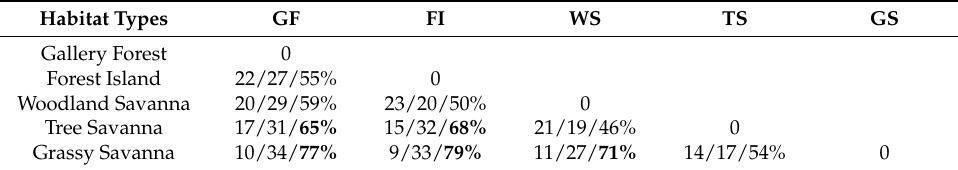
Table 2. Dissimilarity assessment of termite assemblages between the visited habitats. Habitat Types GF FI WS TS GS Gallery Forest 0 Forest Island